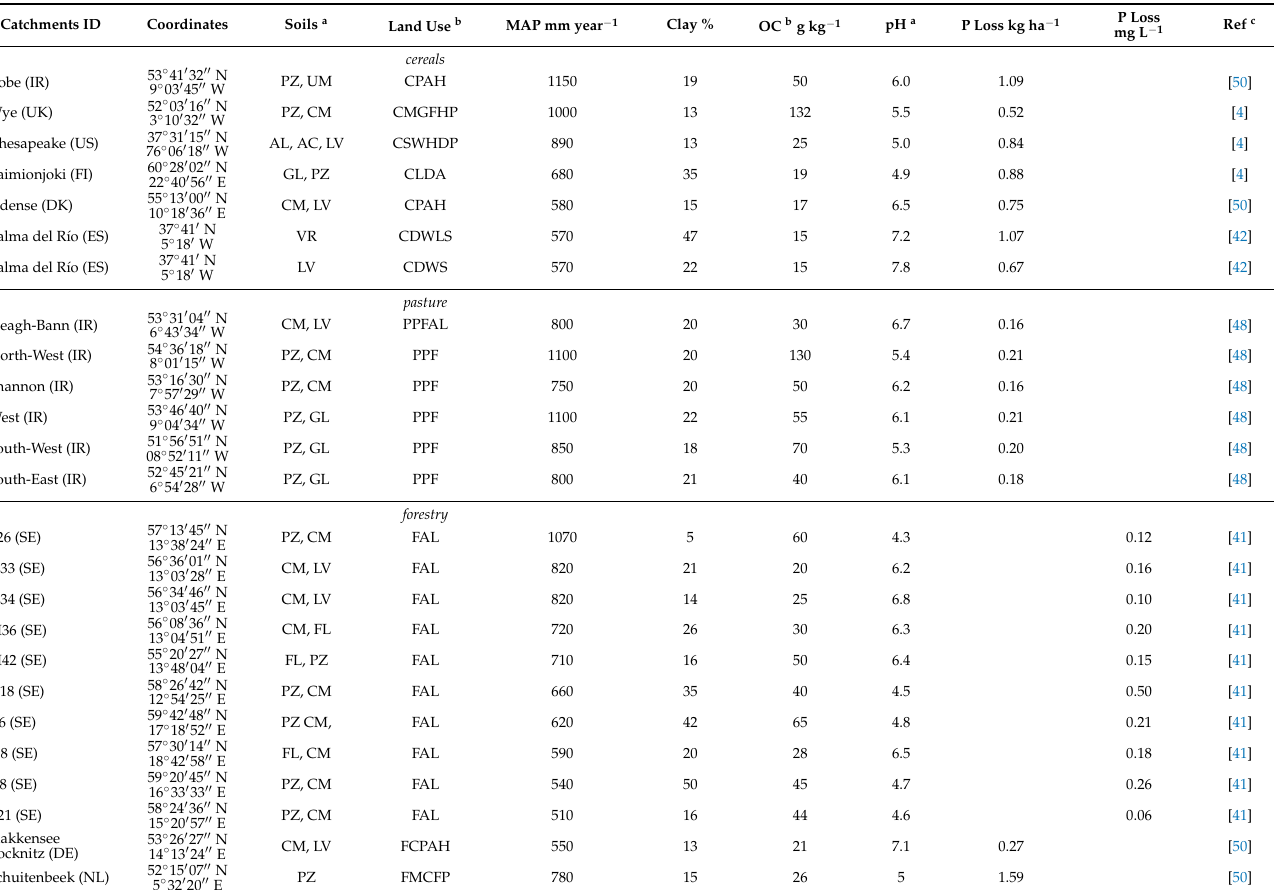
Table 2. General characteristics of the catchment area sorted by land use. The quantities of phos- phorus lost from soils entering surface waters or the P content in the surface waters of the basin are also